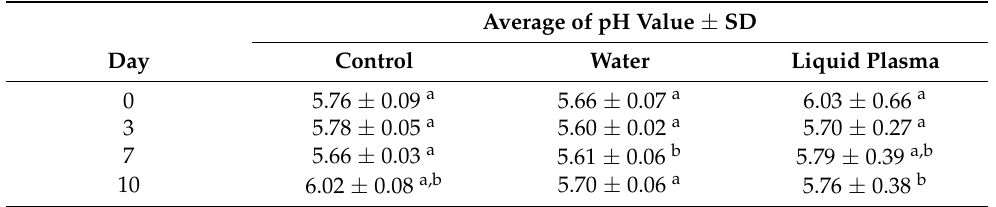
Table 5. Averages of the pH value on the surface of the pork samples ( n = 9).